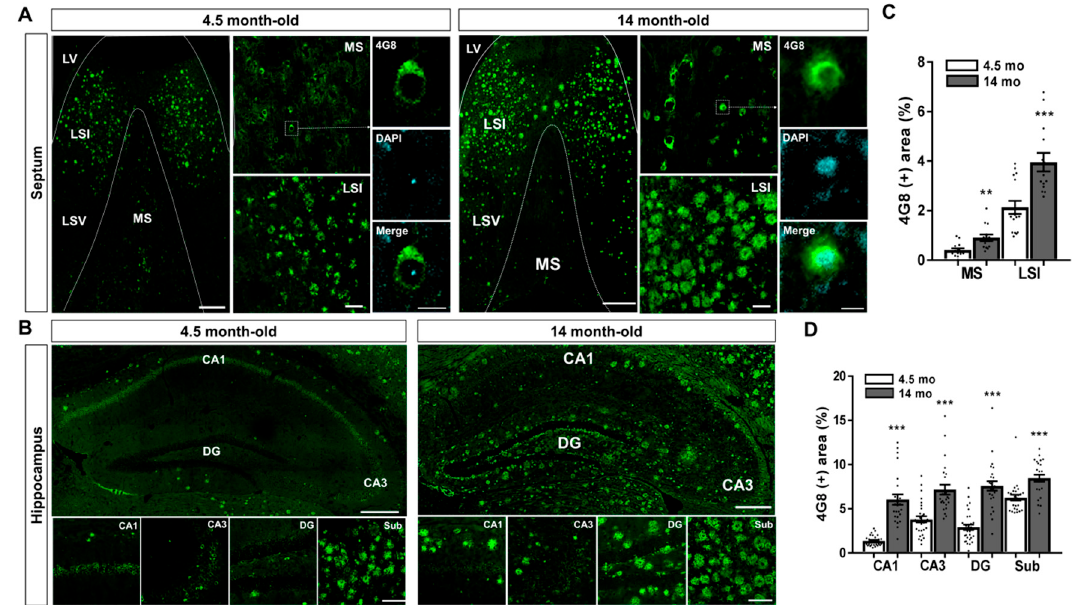
Figure 1. Amyloid- β (A β ) deposition in the brain of the A β -overexpressing mice. ( A , B ) Visualization of A β accumulation in the MS and hippocampal formation by immunohistochemical staining with anti-4G8 antibody in brain sections of 4.5- and 14-month-old five familial AD mutations (5XFAD) mice. ( C ) Quantification of the 4G8 ( + ) areas in the MS and LSI of the 5XFAD mice. ( D ) Quantification of the 4G8 ( + ) areas in the CA1, CA3, DG, and Sub of the 5XFAD mice. ** p < 0.01 and *** p < 0.001 indicate significant di ff erences between the 4.5- and 14-month old 5XFAD mice. Scale bar = 250 µ m for hippocampus and septum; Scale bar = 40 µ m for MS, LSI, CA1, CA3, DG, and Sub. Scale bar = 10 µ m for MS. LV, lateral ventricle; LSI, lateral septal nucleus intermediate part; LSV, lateral septal nucleus ventral part oriens; MS, medial septal nucleus; DG, dentate gyrus; Sub, subiculum (n = 20–35 images / group).